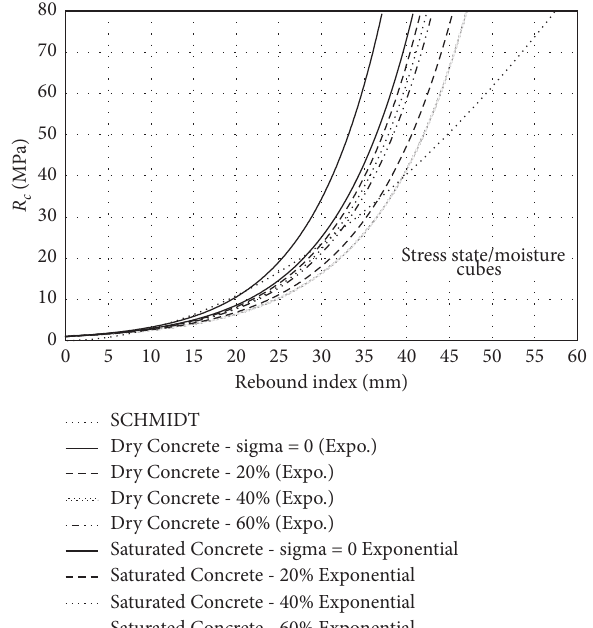
Figure 11: Calibration curves for moisture content and loading conditions (% of the ultimate load). Calibration curve: R RI � rebound index; a ∈ [0.094, 0.120]; R 2 � [0.62, 0.97].